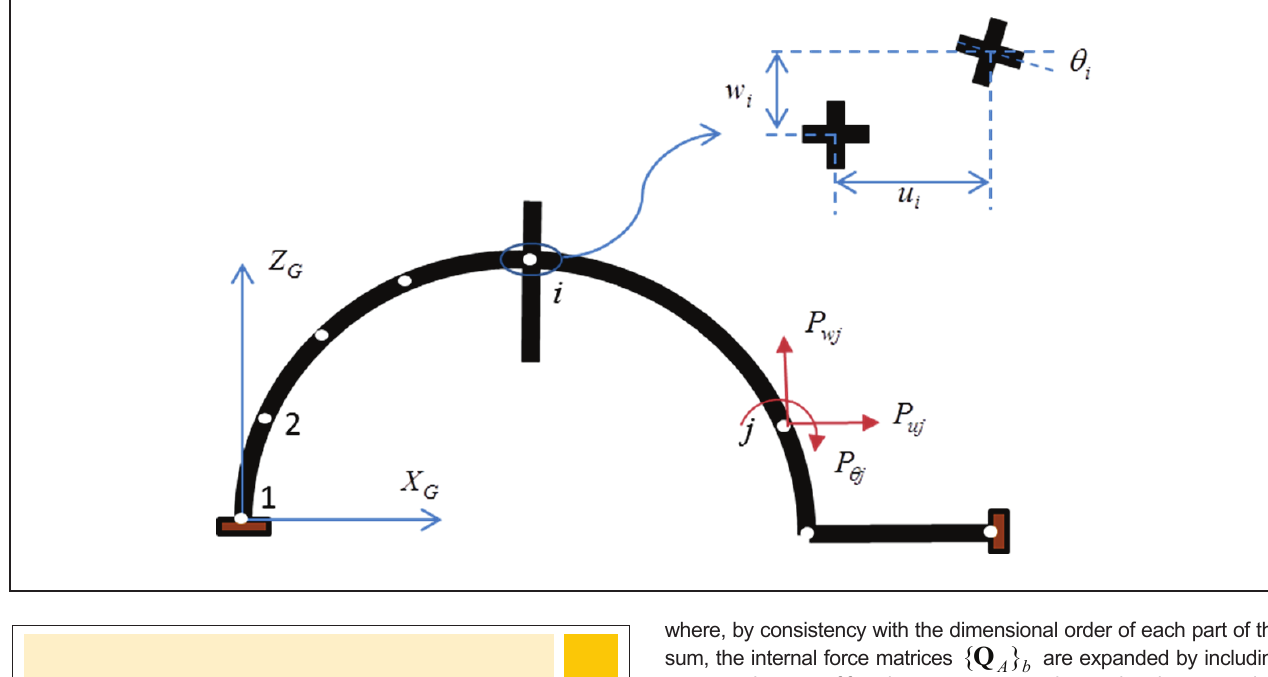
sum, the internal force matrices